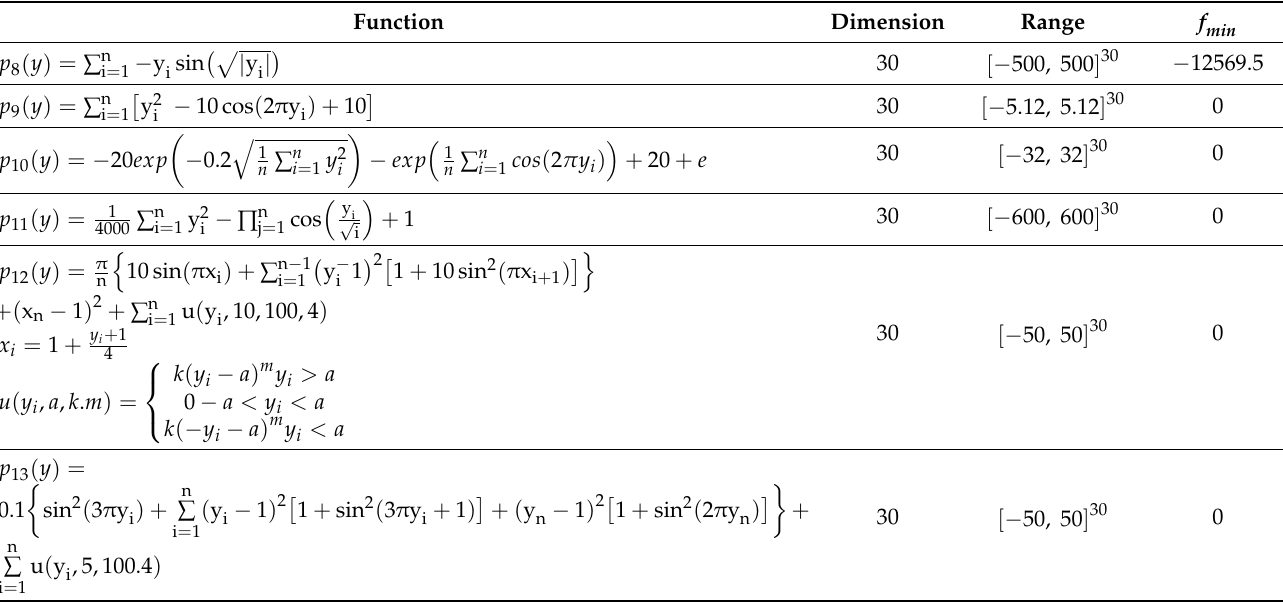
Table 3. Multimodal benchmark function (30-dimensional). Function Dimension